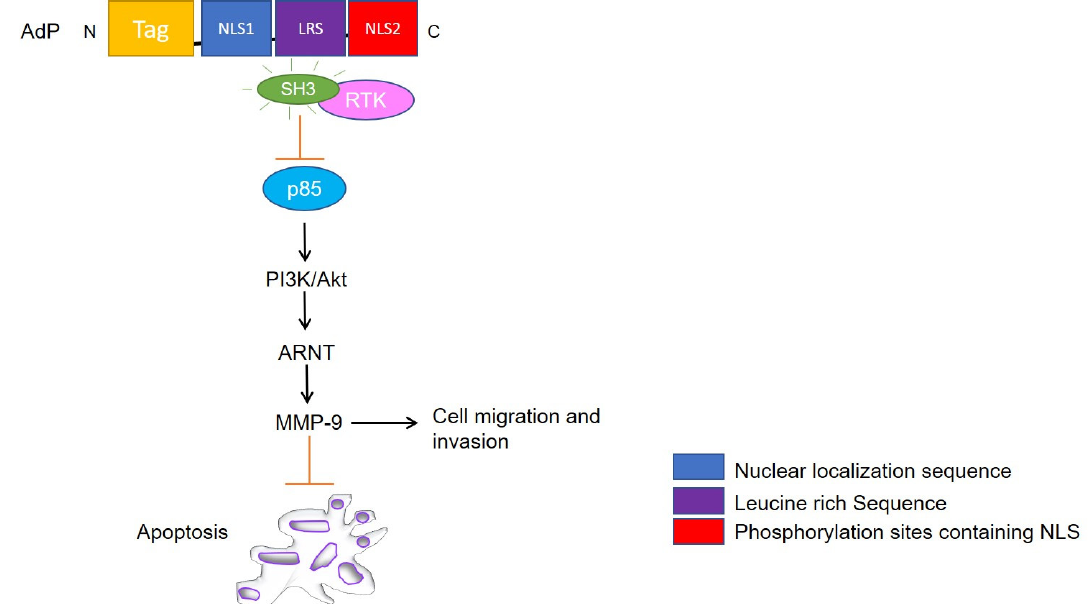
Figure 3. Schematic representation of apoptin derived peptide (AdP) targeted signaling pathways. AdP binds to SRC- homology 3 (SH3) domain of tyrosine kinases and deactivates PI3K/Akt pathway followed by Aryl hydrocarbon nuclear translocator (ARNT) signaling and MMP-9 suppression leading to inhibition of cell migration along mediating apoptosis.